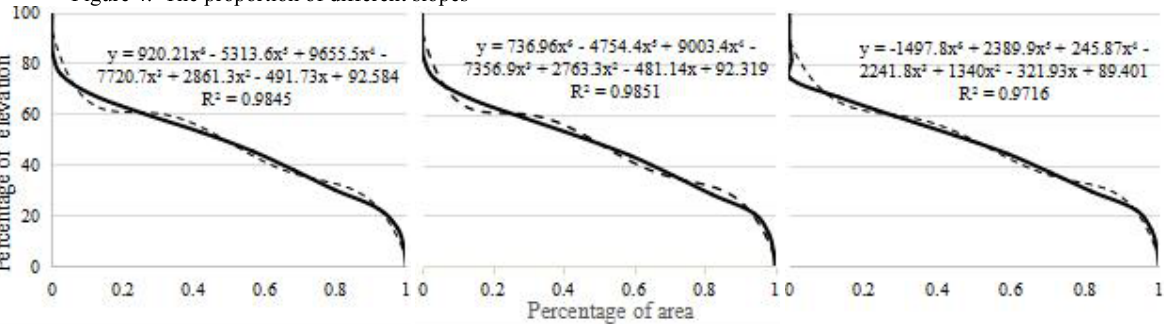
Figure 4. The proportion of different slopes